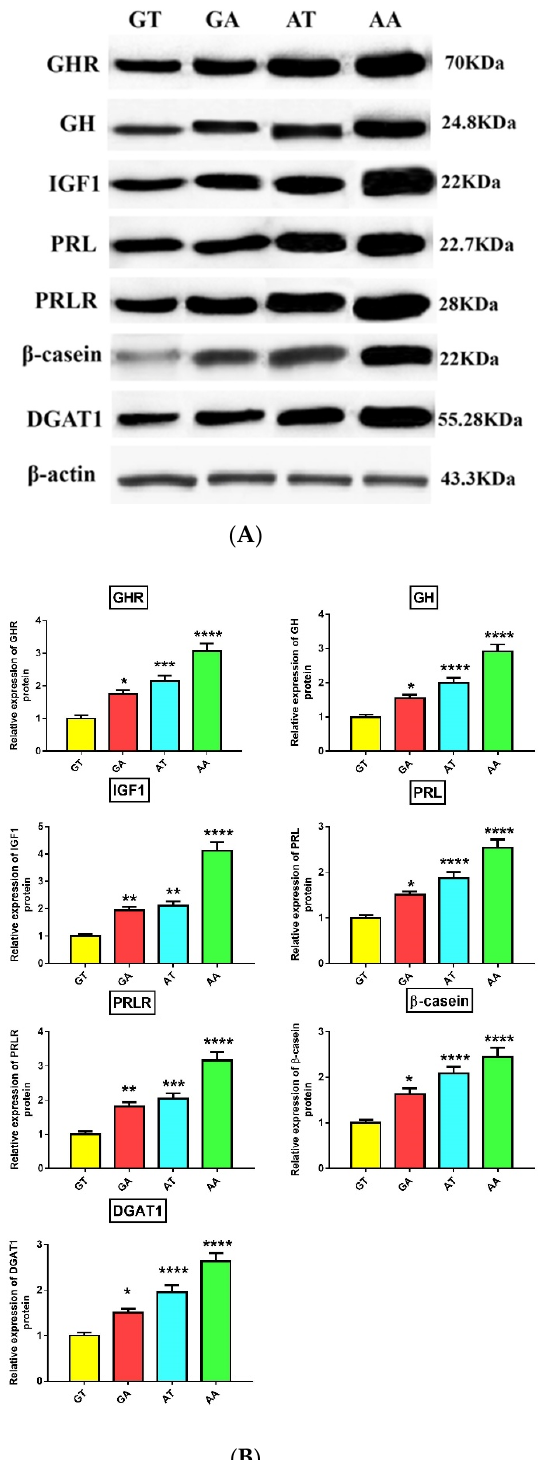
Figure 3. ( A ) Associations between GT, GA, AT, and AA haplotypes and expression of GHR, GH, IGF1, PRL, PRLR, β -casein, and DGAT1 proteins in the milk somatic cells as detected by western blot. The β -actin protein was used as an internal control. ( B ) Band quantification of proteins displayed in (A). Data are presented as mean of protein expression fold change ± SEM (n = 9/haplotype) with GT haplotype considered as the baseline. * p < 0.05, ** p < 0.01, *** p < 0.001, and **** p < 0.0001. All p -values were obtained using Bonferroni’s correction for comparison of all haplotypes against wild haplotype